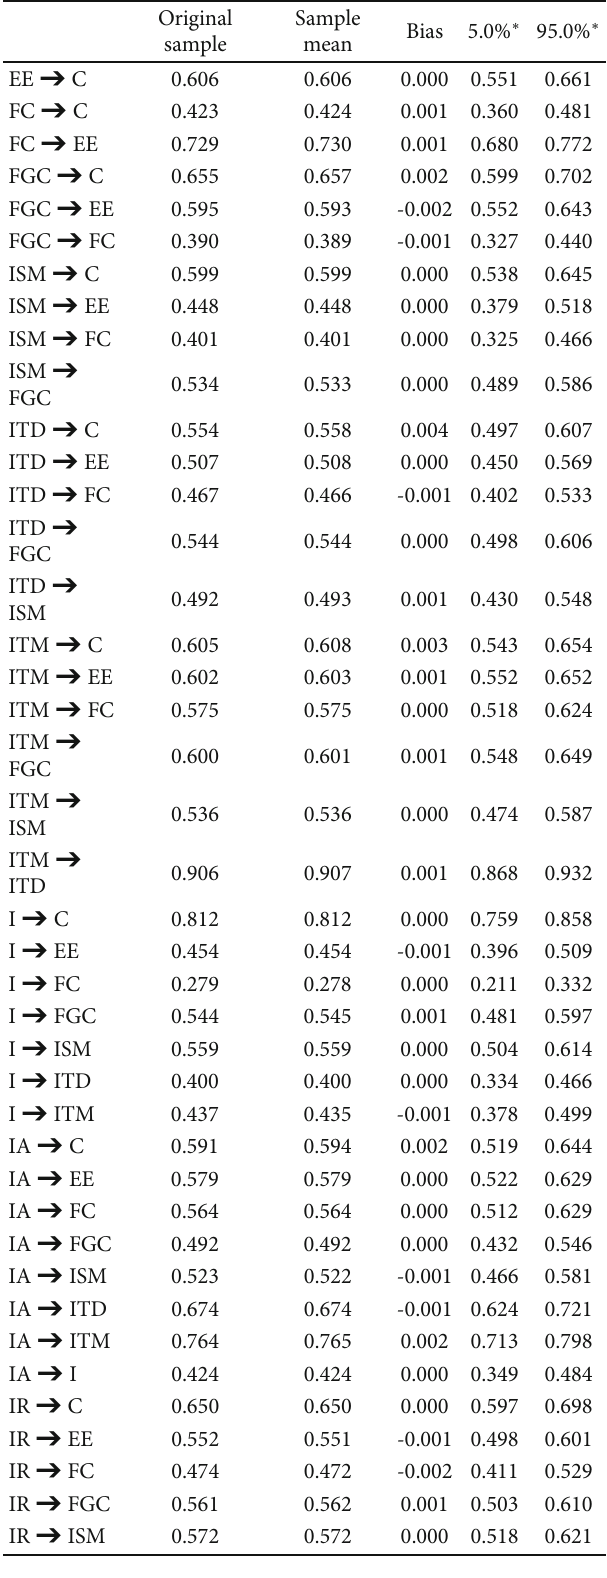
Table 11: Heterotrait-monotrait ratio results for discriminant validity with average HTMT computed from 5000 bootstrap